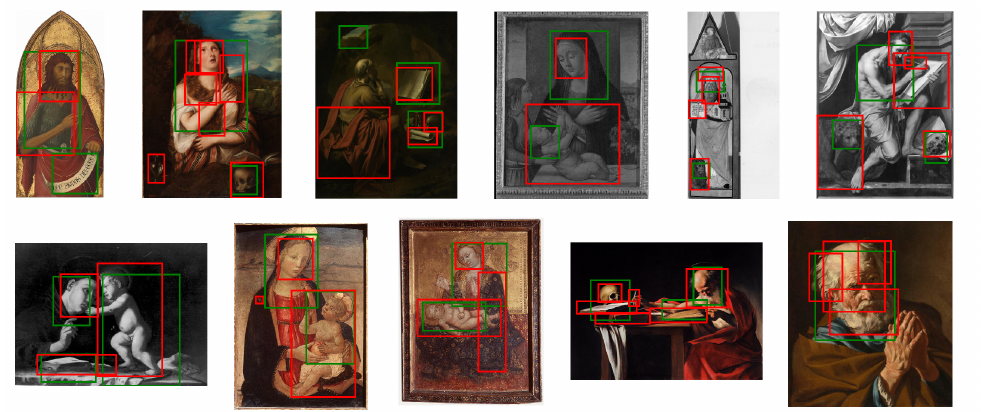
Figure 19. Examples of symbols bounding boxes generated from Grad-CAM (green) and manually annotated (red).